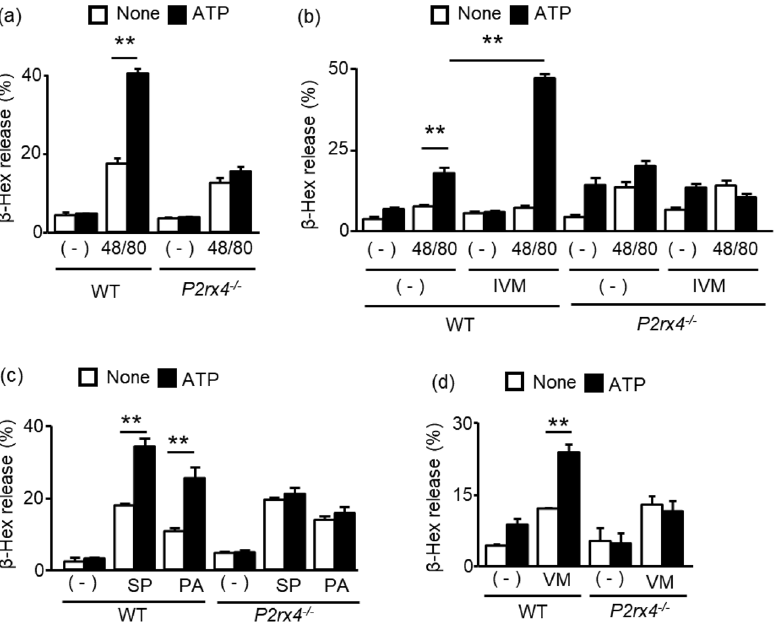
Figure 2. Role of P2X4R in ATP-induced enhancement of degranulation responses to MrgprB2 agonists. ( a ) WT or P2rx4 −/− PMCs were stimulated with CP48/80 (48/80, 1 μM) in the presence or absence of ATP (100 μM). ( b ) WT or P2rx4 −/− PMCs were stimulated with 48/80 (1 μM) and ATP (100 μM) in the presence or absence of ivermectin (IVM, 1 μg/ml). ( c and d ) WT or P2rx4 −/− PMCs were stimulated with Substance P (SP,